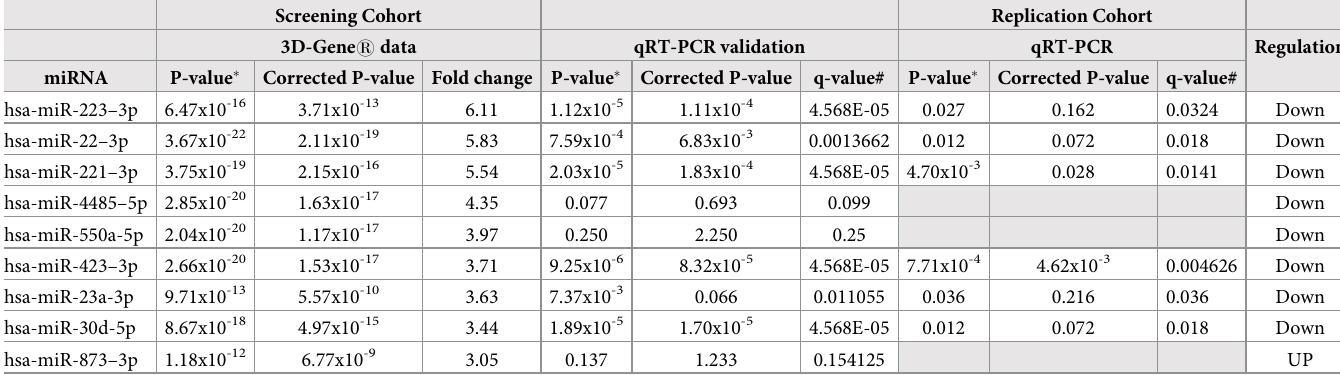
Table 1. Difference of miRNA expression between BrS patients and controls in the screening and replication